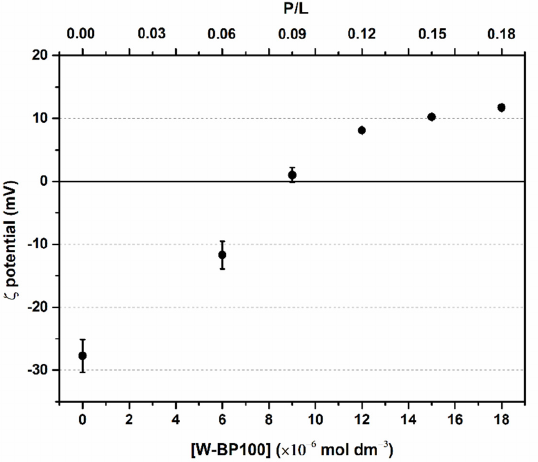
Figure 2. Zeta potential analysis of anionic LUVs at increasing W-BP100 concentrations. The charge of 100 µmol dm − 3 POPC:POPG (1:1) LUVs was measured in the absence and presence of W-BP100 in HEPES buffer, pH 7.4, at 25.0 ± 0.1 °C. Data are the mean ± SD of two independent